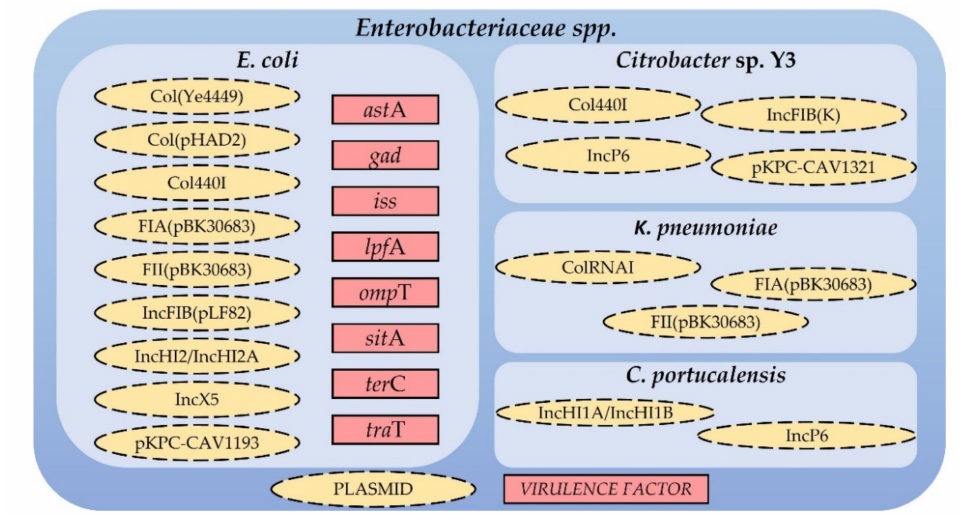
Figure 2. Plasmids found in the whole genomes of the carbapenem resistant Enterobacteriaceae isolated from the discharged effluent samples and virulence factors found in the E. coli isolate.